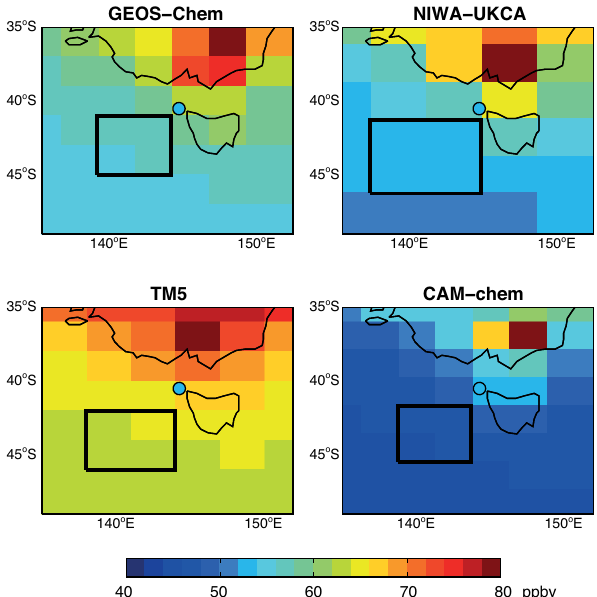
Figure 2. The 5-year (2004–2008) mean surface CO mixing ratios from the four SHMIP models in the vicinity of Cape Grim. The circle shows the multi-year (1991–2000) mean observed CO below 500m from CGOP, plotted at the location of typical vertical pro- filing. Black boxes indicate the four grid squares of the clean air Cape Grim background region sampled in each model for compari- son with the aircraft observations, as described in the text.